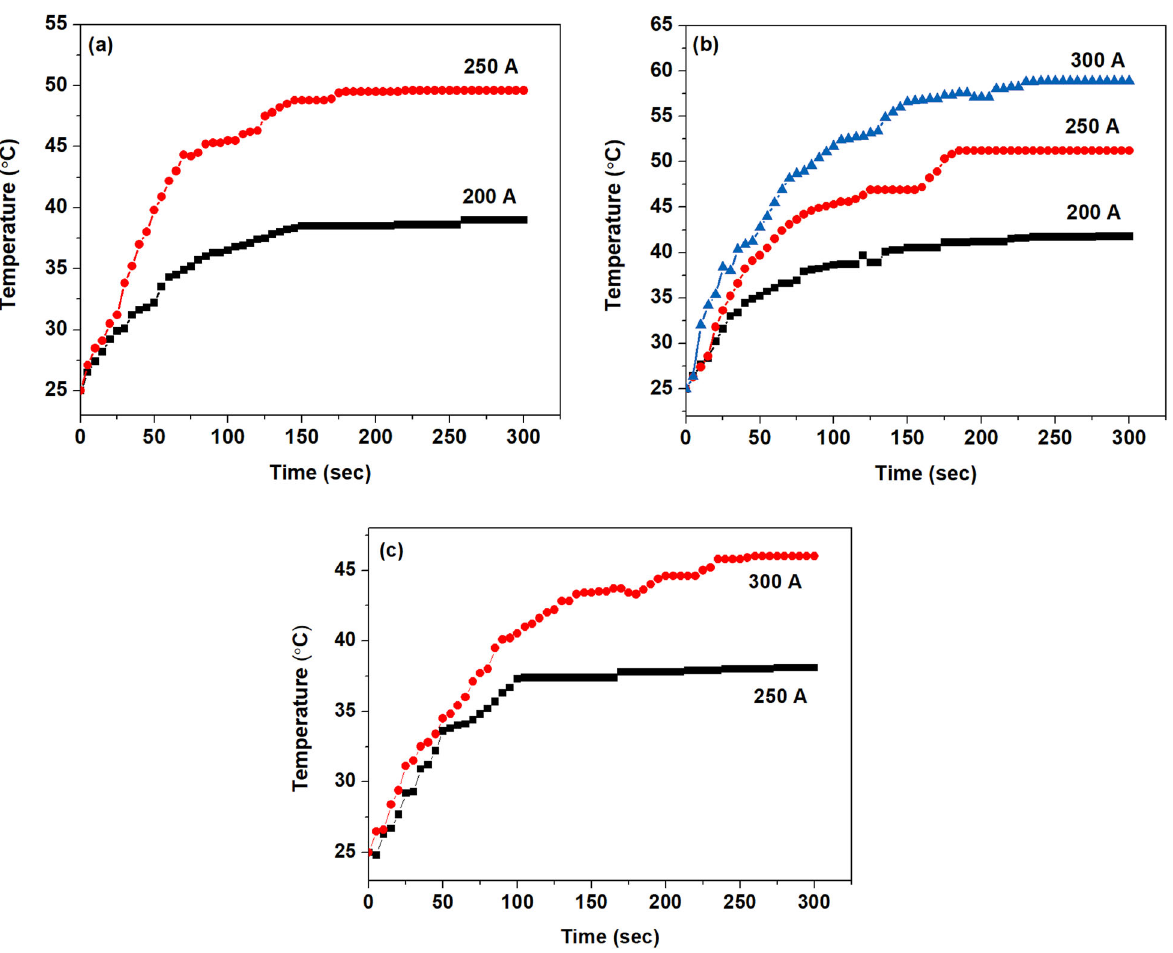
Fig. 11 Time – temperature graph of a Fe 3 O 4 , b PANI-coated Fe 3 O 4 , and c polypyrrole-coated Fe 3 O 4 of 3 mg concentration on exposure to 200 – 400 A (ac) current with a frequency of 280 kHz Table 1 Speci fi c loss power values of the samples based on hyperthermia studies with an applied alternating current at a frequency of 280 kHz